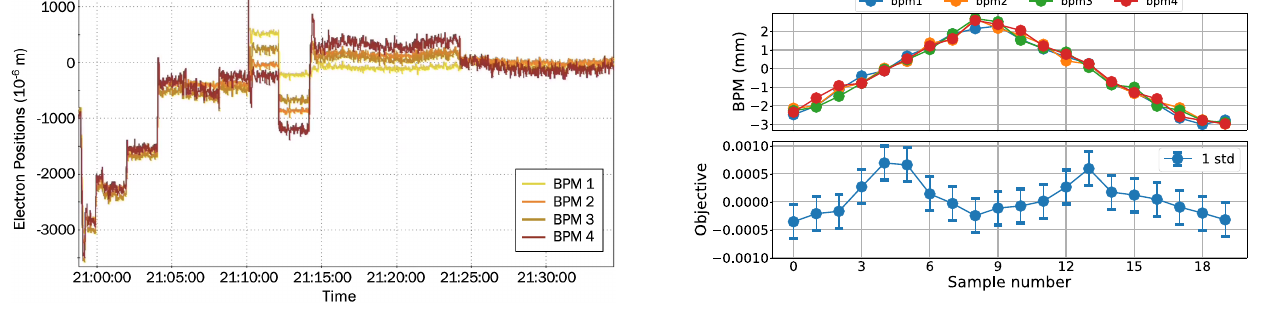
FIG. 11. After training, the algorithm is used to control the electron beam trajectories. As we can see, the algorithm tunes the electrons back to the center and maintains it there, which in turns verifies the correctness of the beam-based alignment method.